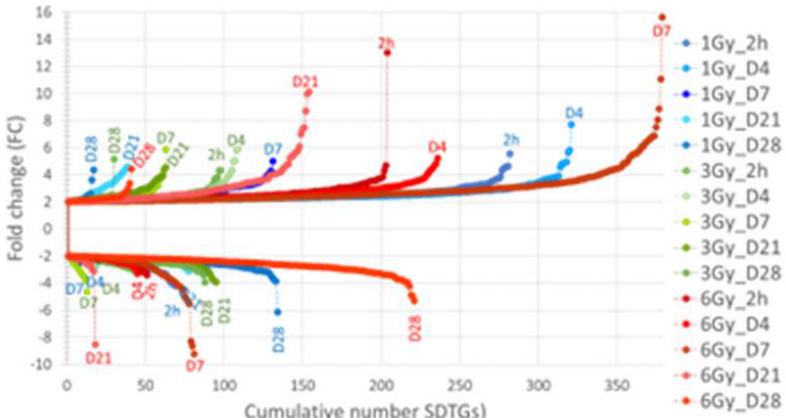
Figure 5. Dot plot showing the number and magnitude of up- and downregulation of SDTGs ( p < 0.05 and FC ≥ 2) in skin biopsies of mice exposed to different to sublethal doses of X-ray radiation. Note the varied patterns between up- and downregulation in each of the three doses and among all three doses.